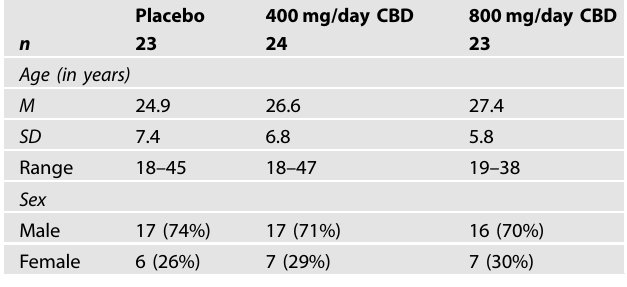
Table 1. Participant characteristics within treatment groups.